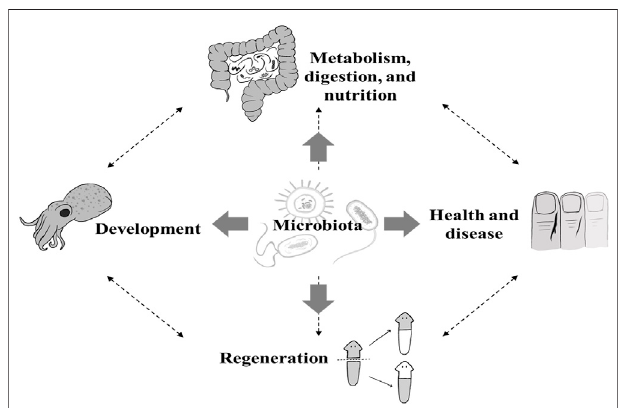
FIGURE 1 | The in fl uence of microbiota on host physiology. This fi gure outlines the aim of this review where we describe the role of the microbial composition associated with an animal host. In this review we focus on the regeneration process. However, we incorporated studies that link the microbiota to the metabolism, digestion and nutrition, health, and development of animal hosts to point out the interconnection between all these processes (dashed